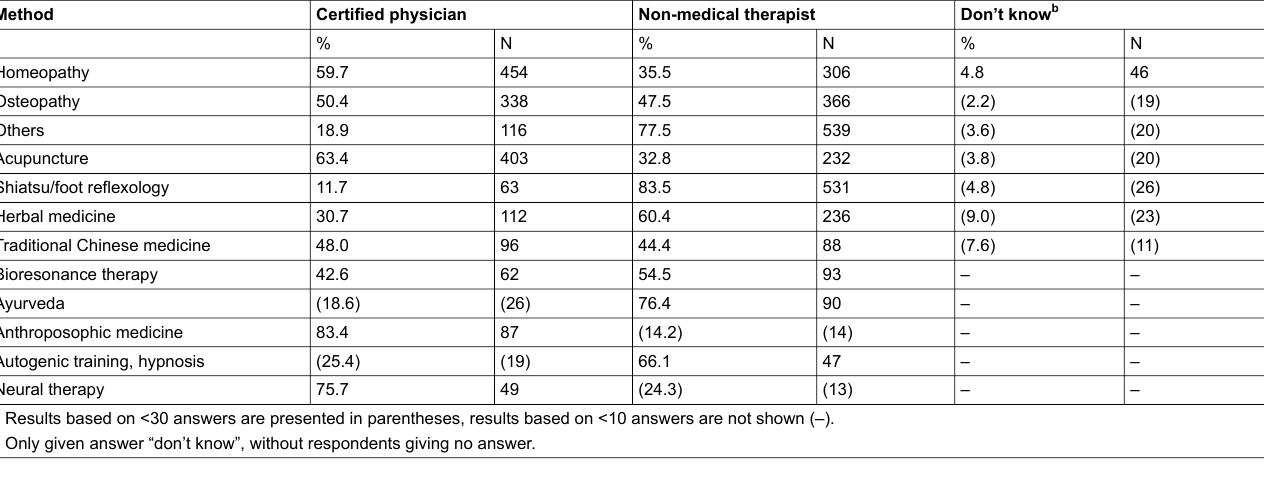
Table 4: Logistic regression model: Usage of CM in the last 12 months (Swiss Health Survey, Switzerland,